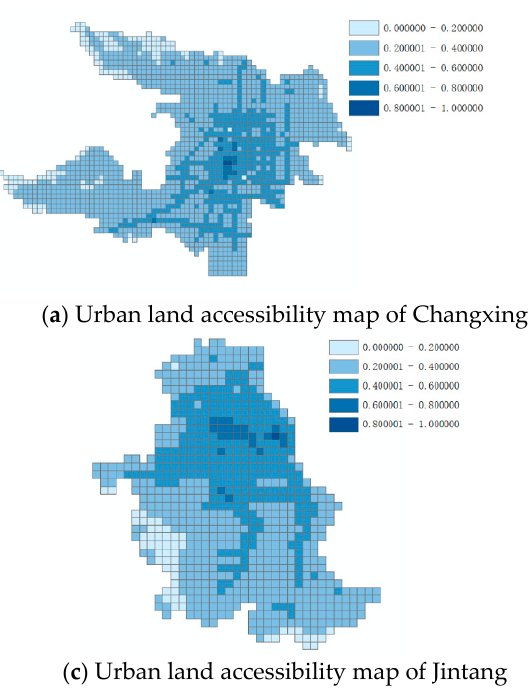
Figure 1. Urban land accessibility map.